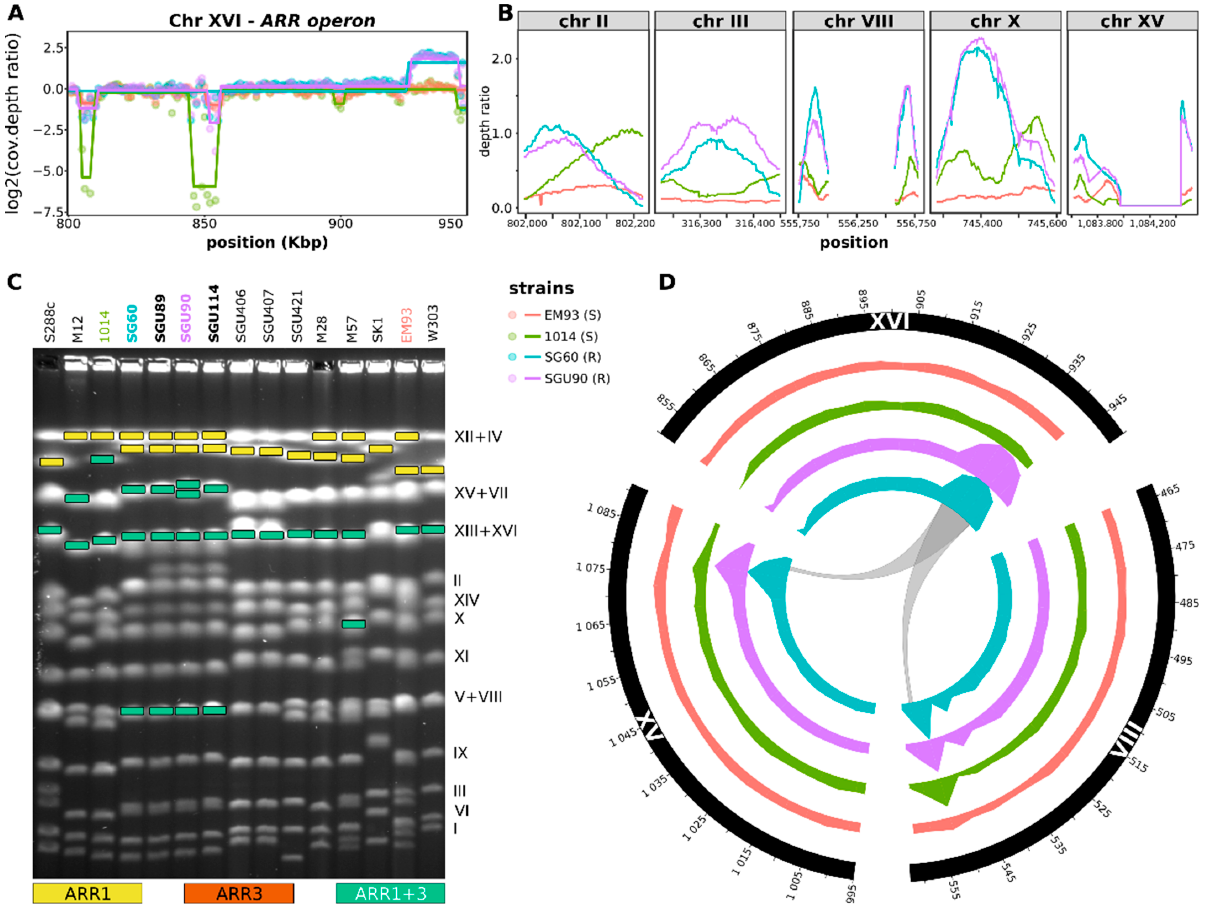
Figure 2. Identification of the duplicated region and its new genomic positions. ( A ) Results of CBS analysis highlighting the region of chromosome XVI encompassing the ARR genes. Points show